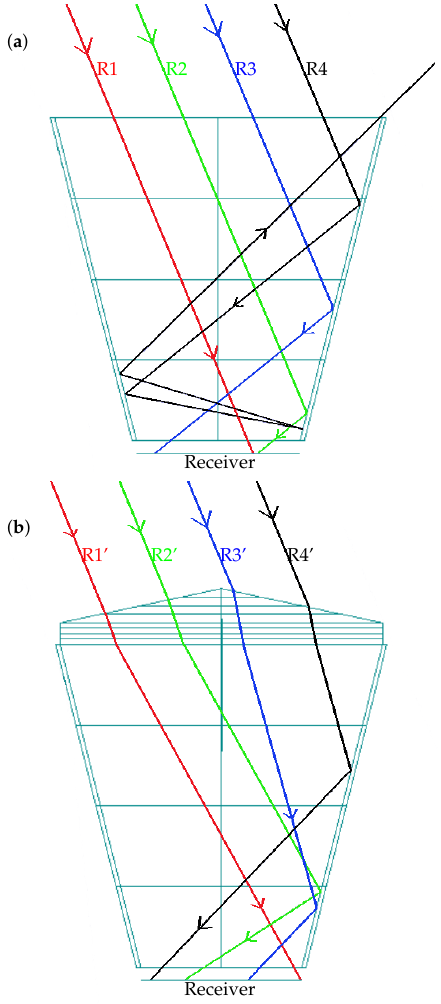
Figure 2. Path of typical rays falling on the system: ( a ) bare funnel concentrator, ( b ) refractive- reflective system, with an incidence angle of θ = 22.5 ◦ .